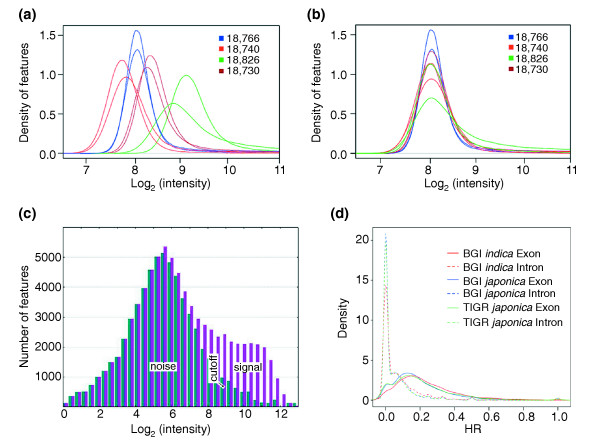
Processing the rice chromosome 10 tiling microarray hybridization data. (a) Distribution of fluorescence intensity of all positive and negative features of the four indica N Arrays. (b) All eight distributions were scaled to have a uniform intensity peak value at 8 (log2). (c) Mathematic model for determination of signal probes. A bimodal distribution of log2 background-adjusted intensity of all positive features is used to model the noise as a normal distribution by mirroring the distribution of low intensity (< 6 of log2). A cutoff value corresponding to a 90% confidence level to reject noise probes according to the modeled noise distribution is indicated. (d) Distribution of hybridization rate in the exonic and intronic regions of rice chromosome 10. Hybridization rate (HR) is calculated as the ratio of the number of signal probes against the total number of interrogating probes per kilobase of sequence.